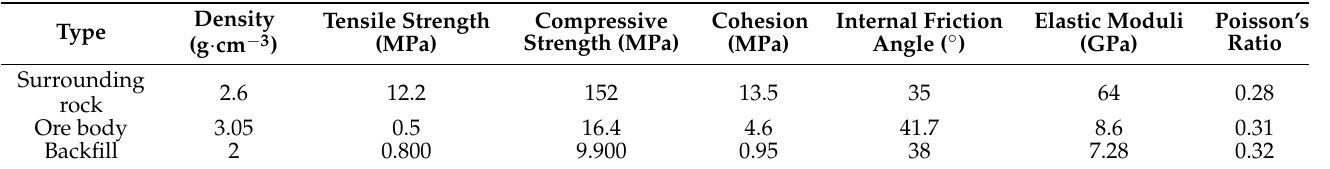
Figure 5. Numerical model and mining-filling steps. Table 1. Rock and backfill mechanical parameters in mining area No. 3 [42].